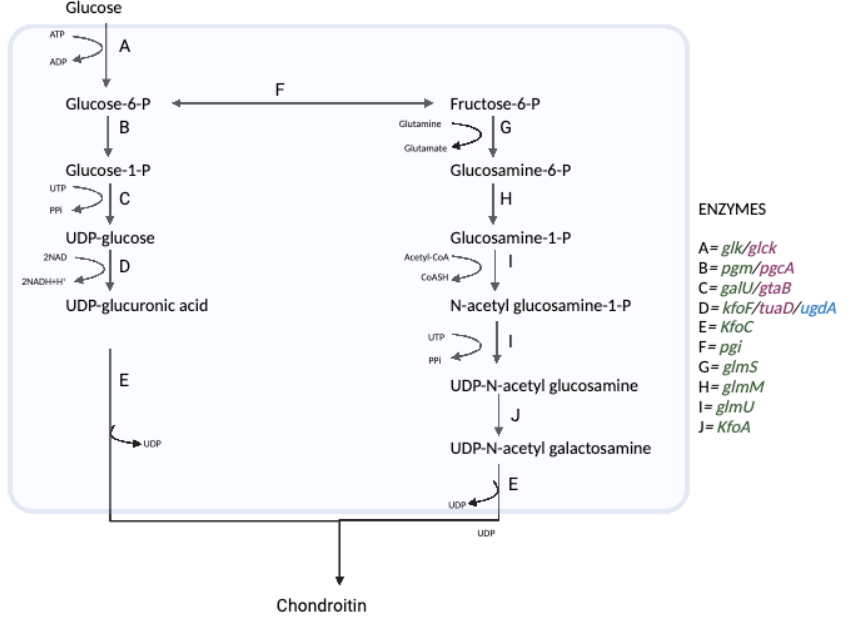
Figure 2. The biosynthetic pathways for chondroitin production in E. coli K4. Enzymes used in E. coli K4 and others are shown in green. Enzyme names used in Bacillus subtilis are shown in purple and enzyme names used in Corynebacterium glutamicum are shown in blue (created with BioRen ‐ der.com).